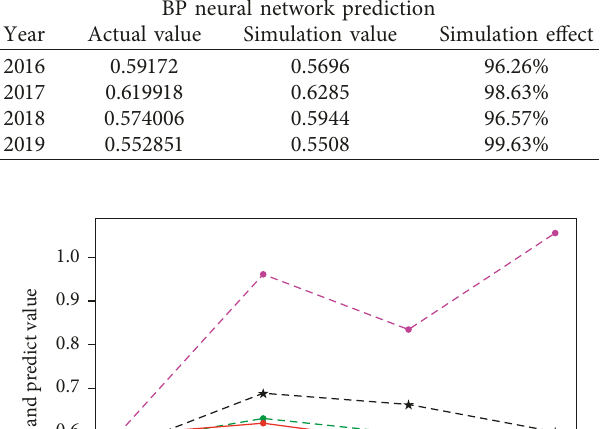
Table 11: Simulation values of BP neural network. BP neural network prediction